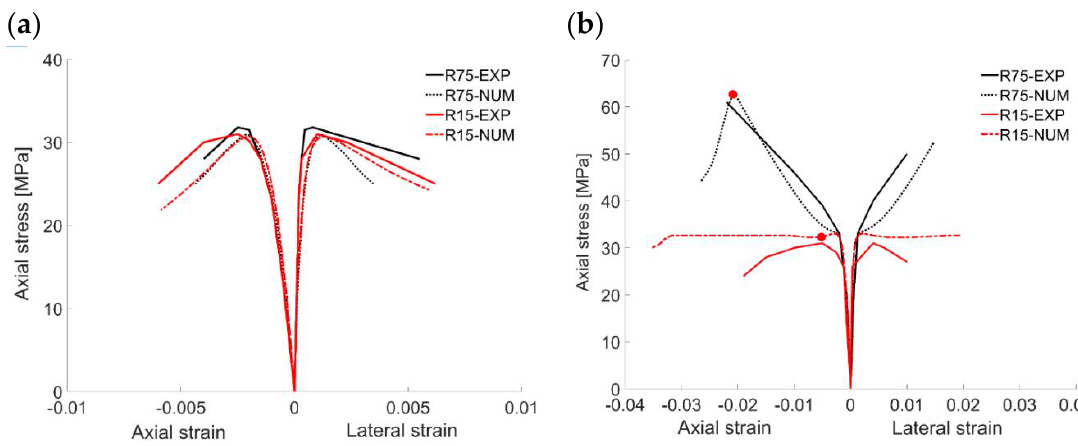
Figure 10. Stress-strain curves for: ( a ) unconfined specimens ( R 15 , R 75) and ( b ) 1ply CFRP-confined specimens ( R 15 , R 75). Table 3. Percentage error with respect to f cc [MPa] from the experiments ( R 15 , R 75).